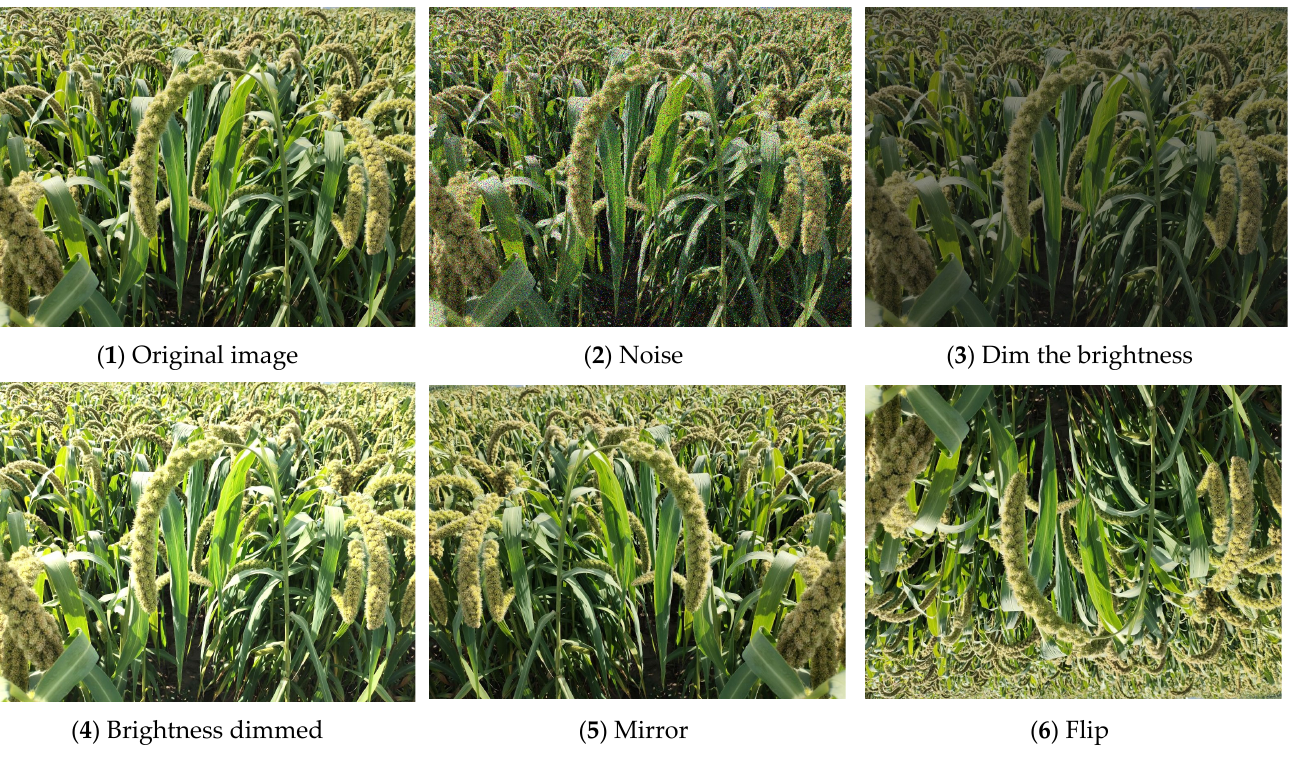
Figure 2. Data augmentation.